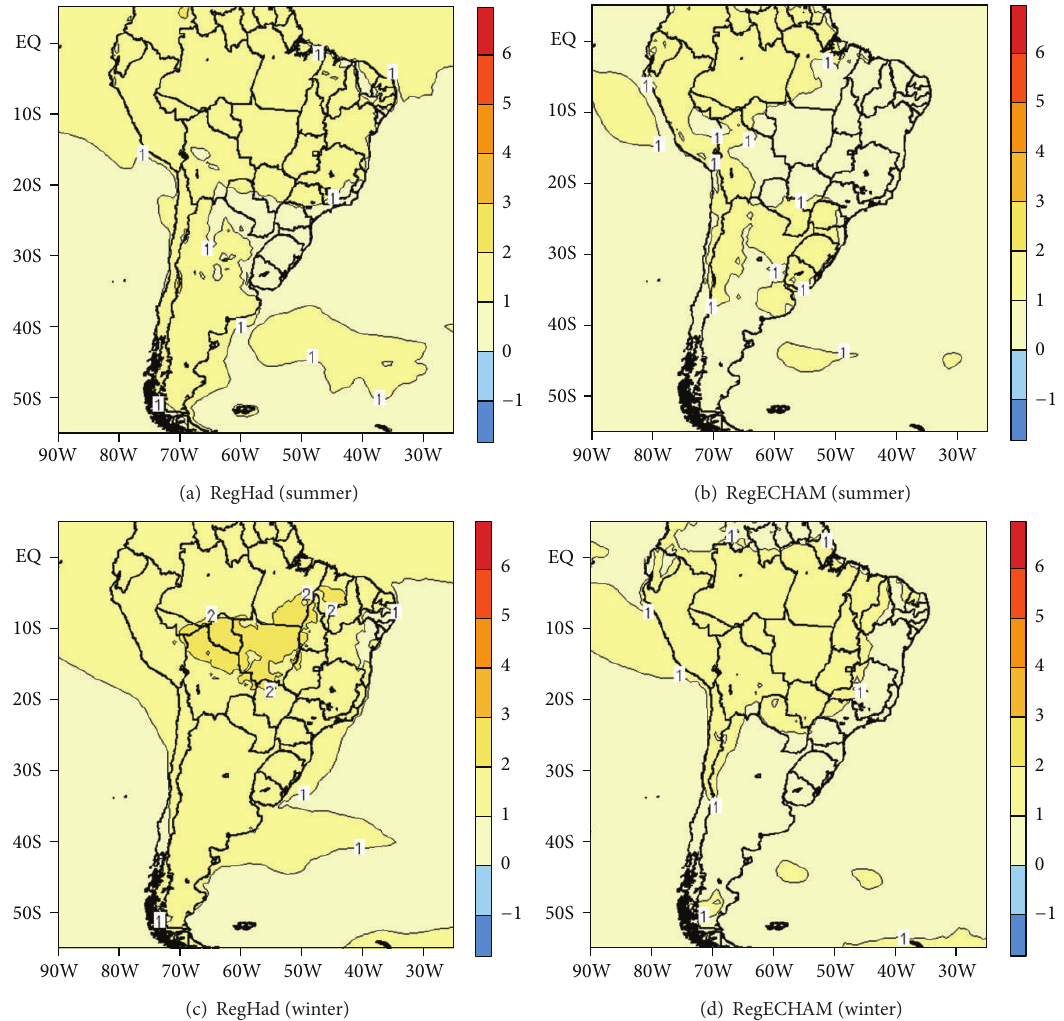
Figure 5: Projected mean change in the near-future climate (2010–2040 minus 1961–1990) of air temperature ( ∘ C) simulated by RegHad (left column) and RegECHAM (right column) for summer (top) and winter